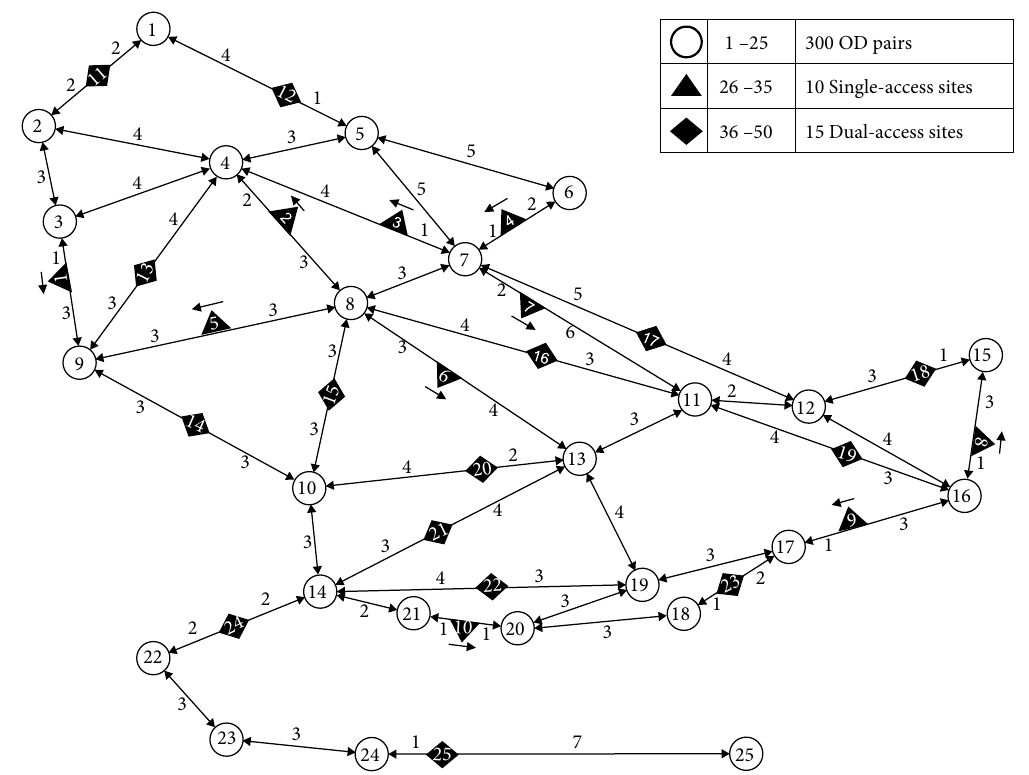
Figure 5: Test network with 300 OD pairs and 25 candidate sites [61]. Table 4: Computational time for